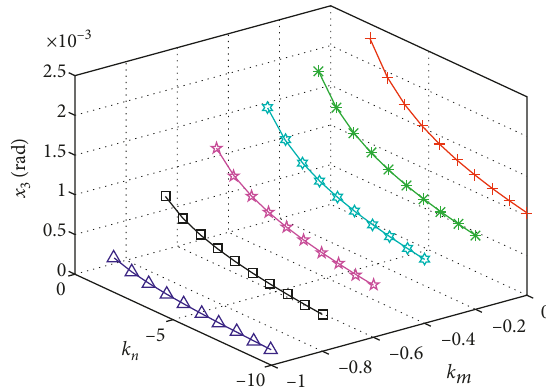
Figure 12: The vibration amplitude variation diagram of k change at the same